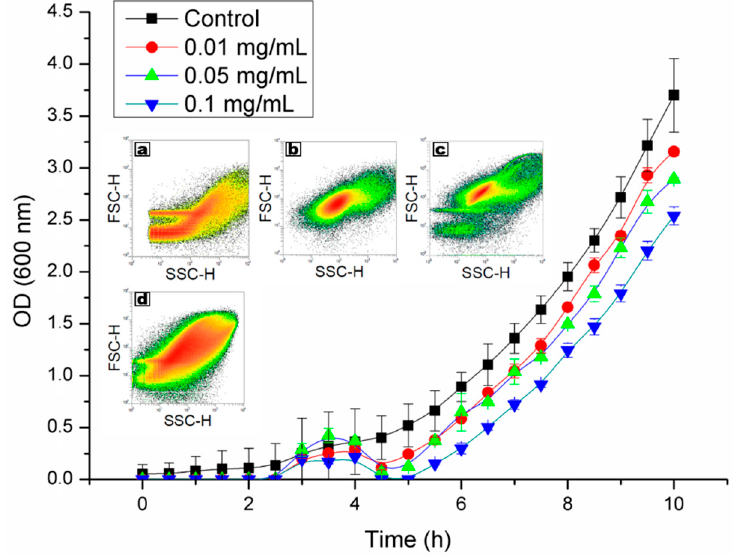
Figure 4. Optical density of Pseudomonas aeruginosa incubated with three concentrations of titanium dioxide/silica nanotubes and cytograms results from nanomaterial dispersed in medium with nanomaterial ( a ), Pseudomonas aeruginosa PAO1 alone ( b ), and with unexposed ( c ) and UV light-exposed ( d ) titanium dioxide/silica nanotubes.